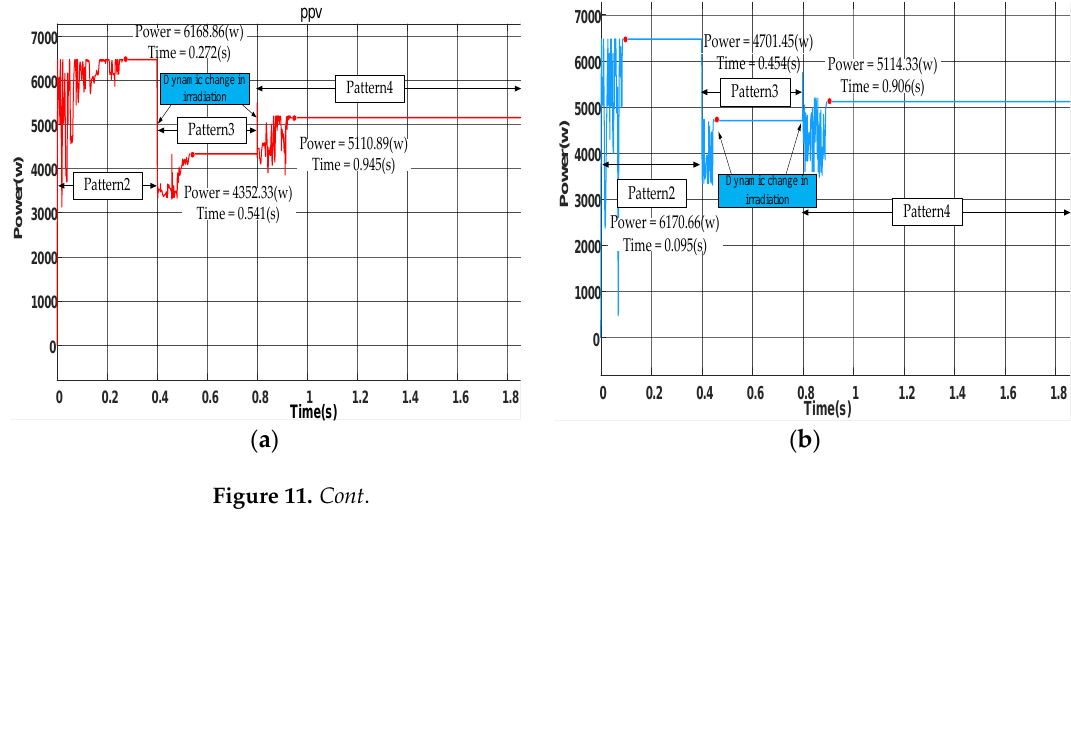
Figure 10. The obtained duty cycle by the algorithms in constant irradiance condition from pattern 1. ( a ) TSO; ( b ) ITSO; ( c ) CS; ( d ) INC.